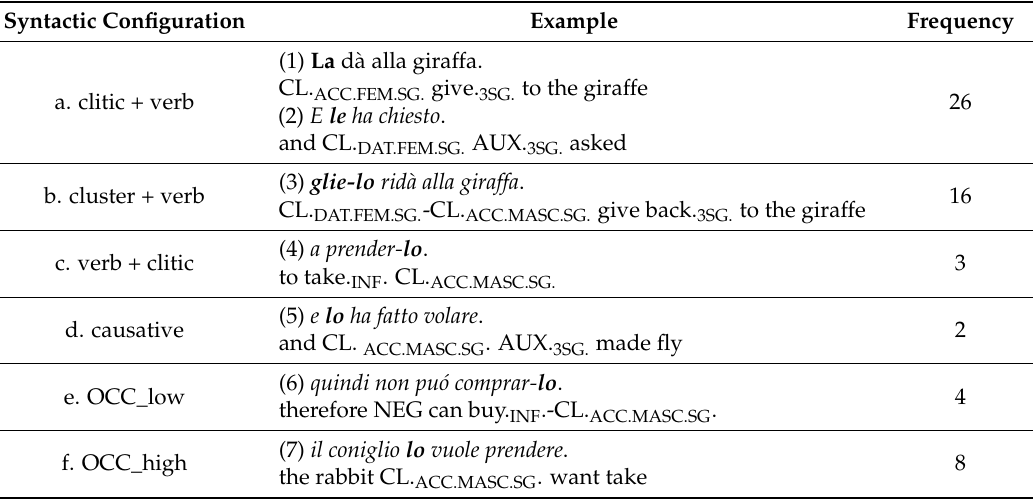
Table 5. Raw frequency of clitic pronouns in different syntactic contexts.